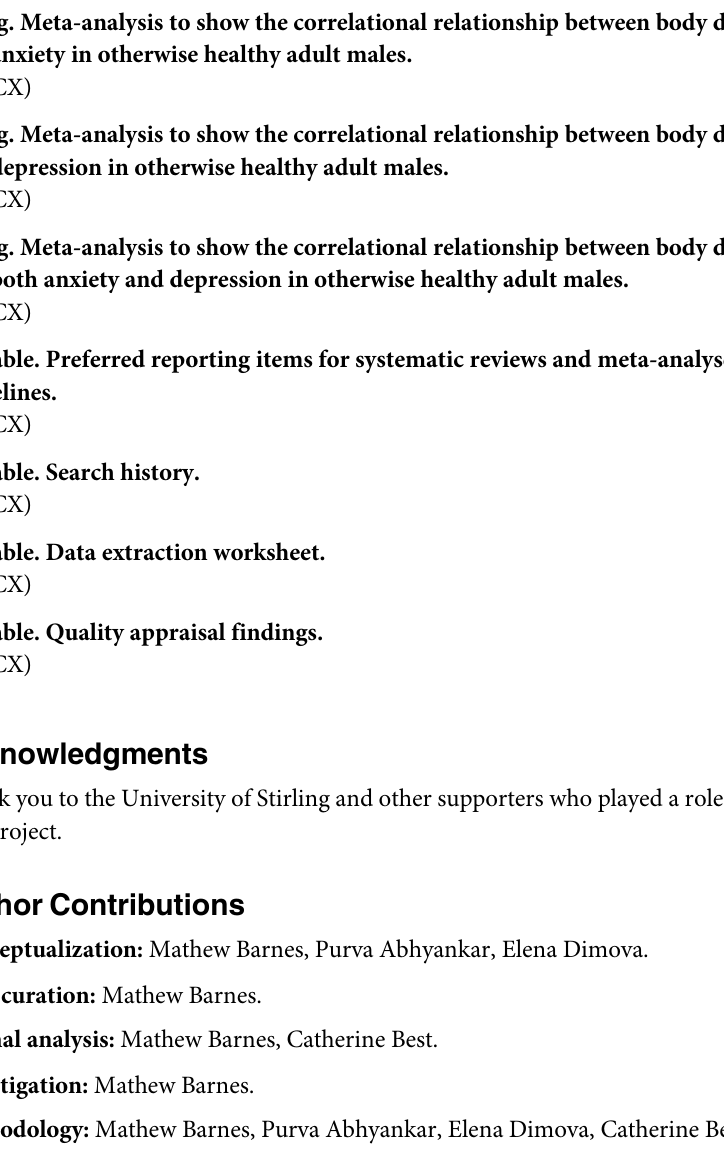
S1 Fig. PRISMA flow chart. S2 Fig. Meta-analysis to show the correlational relationship between body dissatisfaction and anxiety in otherwise healthy adult males. S3 Fig. Meta-analysis to show the correlational relationship between body dissatisfaction and depression in otherwise healthy adult males. S4 Fig. Meta-analysis to show the correlational relationship between body dissatisfaction and both anxiety and depression in otherwise healthy adult males.